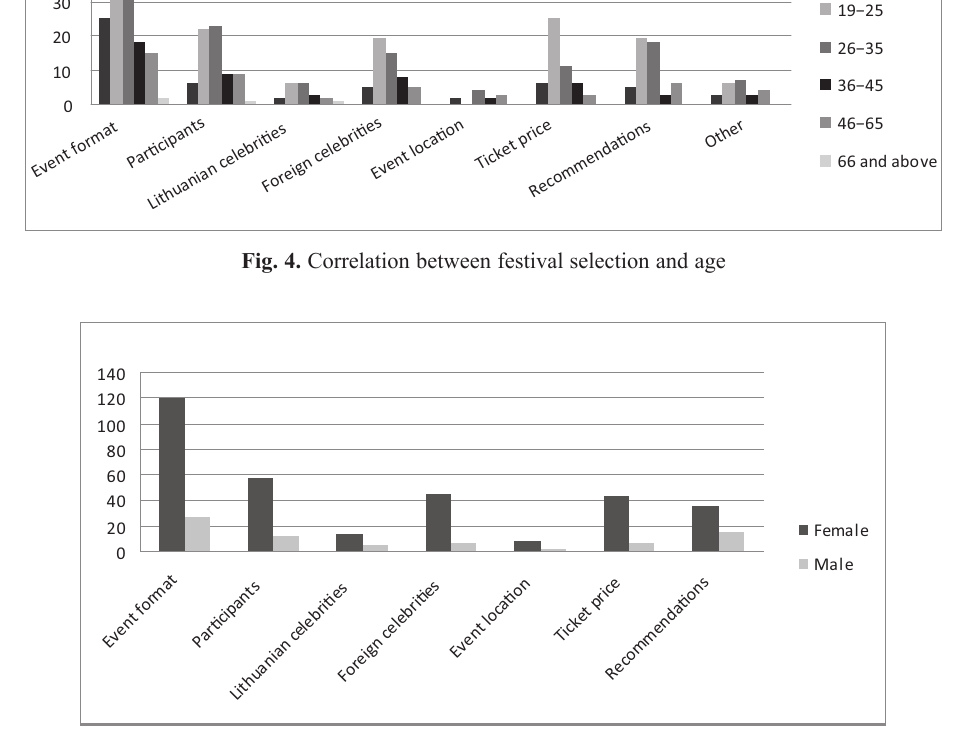
Fig. 5. Correlation between festival selection and gender